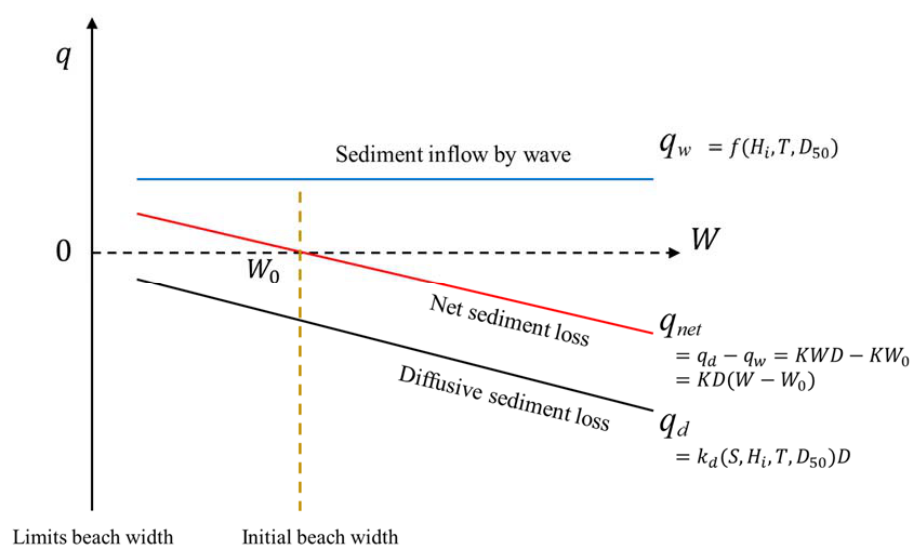
Figure 7. Conceptual diagram of coastal sediment loss rate ( 𝐾 ).